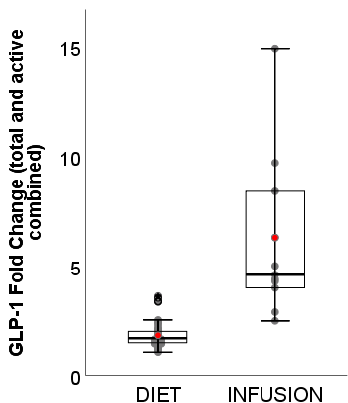
Figure 6. Boxplots showing fold change of GLP-1 (total and active) between DIET (N = 1162, K = 66) and INFUSION (N = 152, K = 11). The weighted means were significantly different between DIET and INFUSION ( p < 0.01).